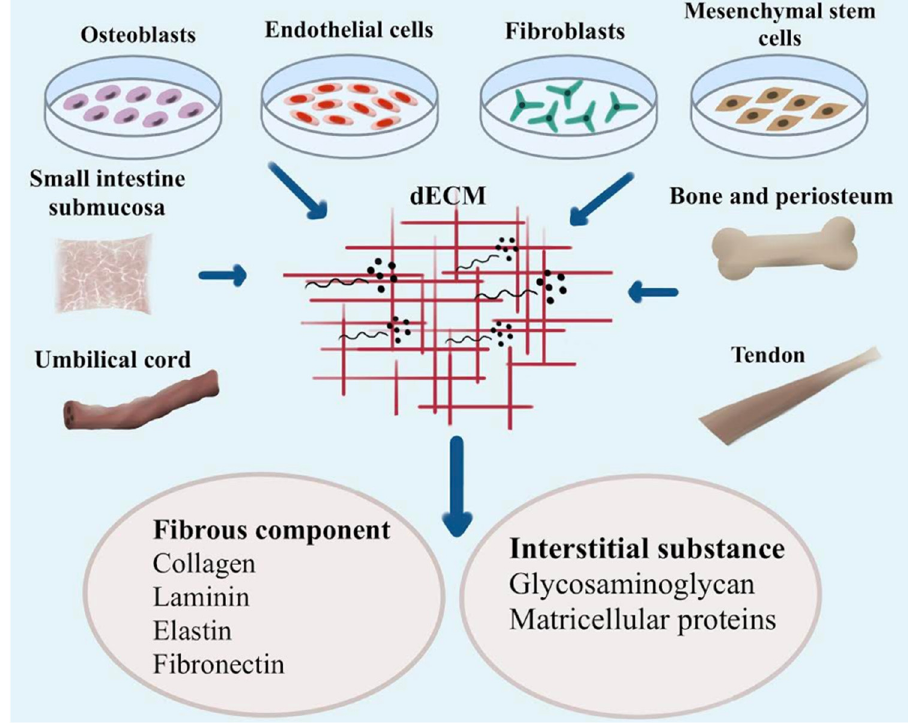
Figure 4. The fibrous component during the process of bone regeneration.